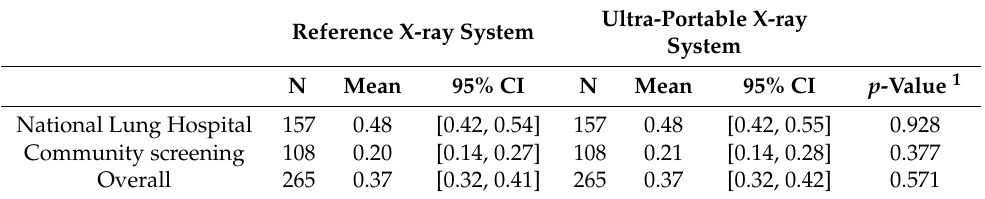
Table 4. Comparison of mean AI scores of the ultra-portable and reference X-ray systems. Reference X-ray